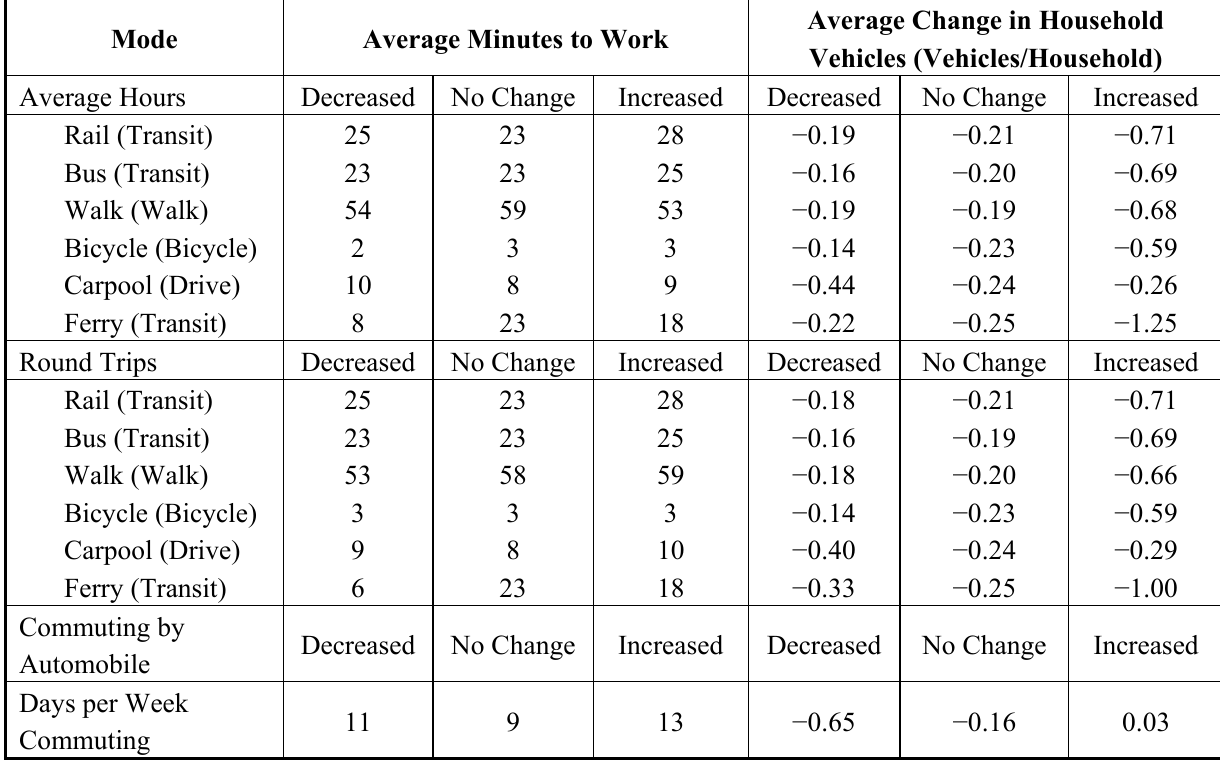
Table 6. Subsample Averages of North American Carsharing Members Surveyed for Time to Work and Change in Average Number of Household